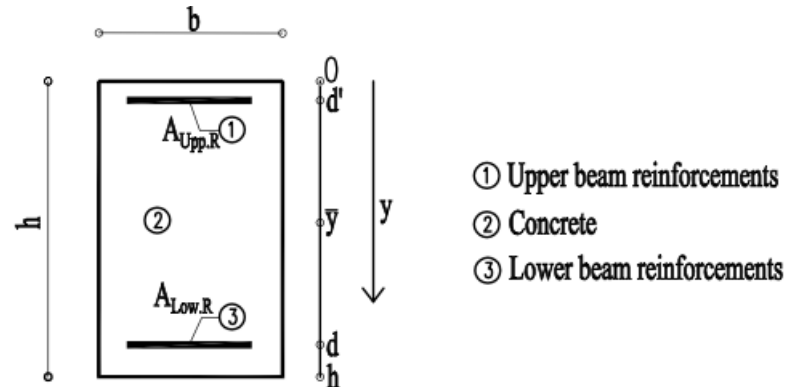
Figure 1. Geometric and dimensional cross-section details.